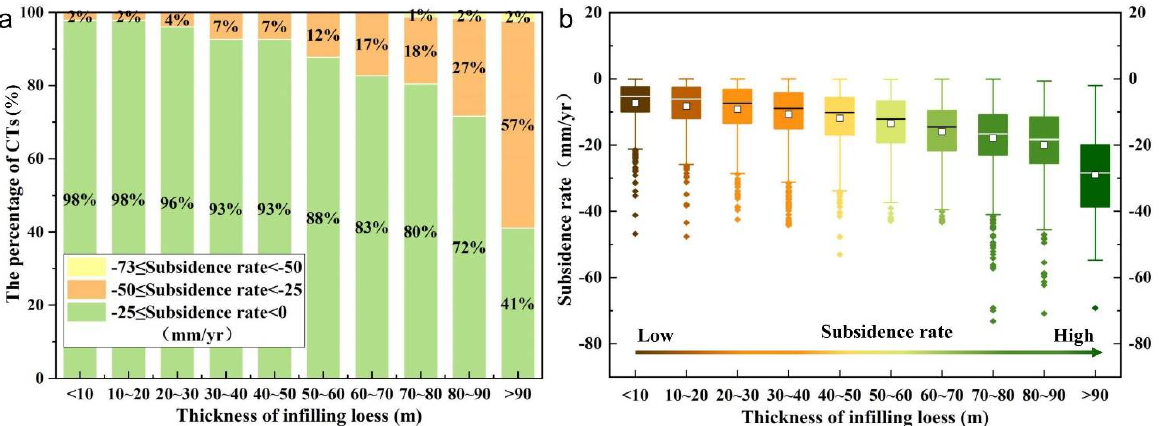
Figure 10. A quantitative relationship between the subsidence and filling thickness. ( a ) Statistics of the CTs for different thicknesses of infilling loess; ( b ) statistics of the deformation rates for different thicknesses of infilling loess.